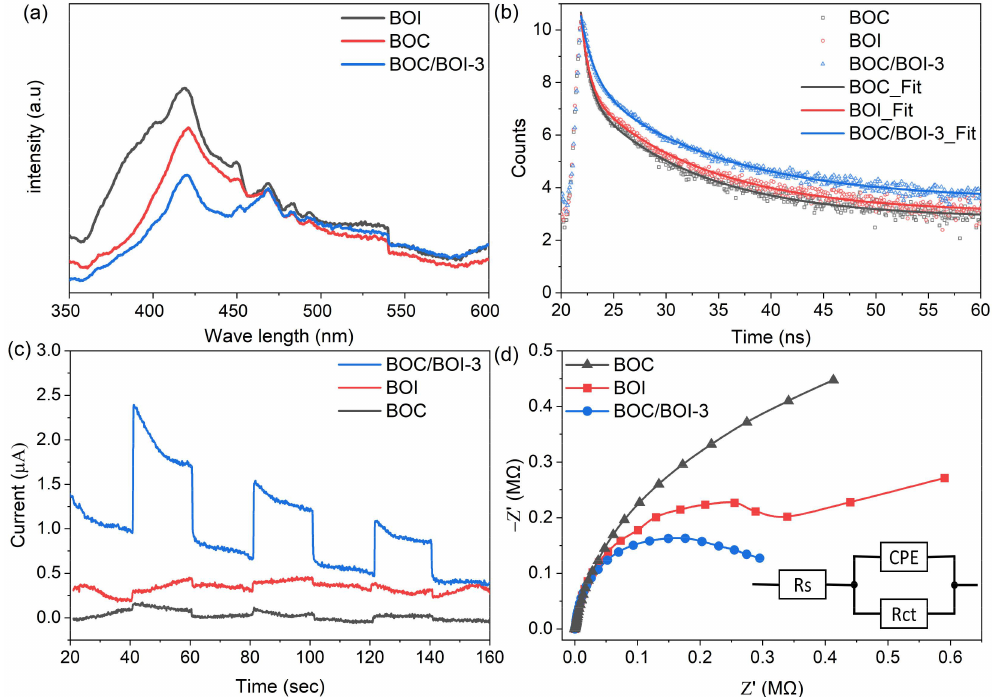
Figure 9. ( a ) Photoluminescence spectra, ( b ) TRPL decay spectra, ( c ), transient photocurrent response and ( d ) EIS Nyquist plots of BOC, BOI, and BOC/BOI-3